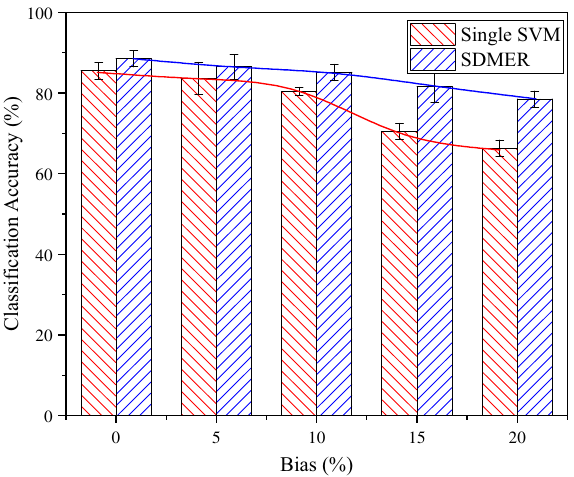
Figure 7. Comparison of classification accuracy in the Single SVM model and the SDMER